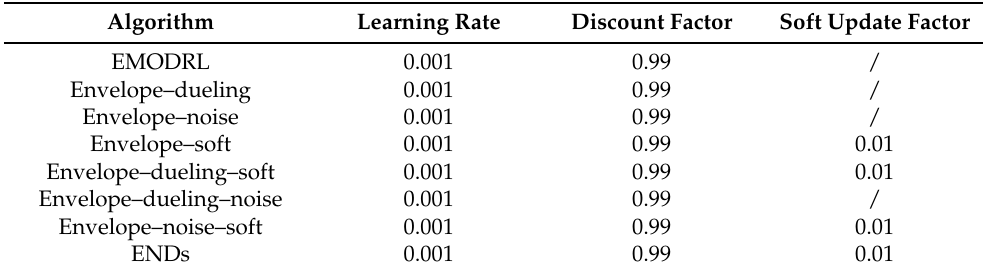
Table 1. Parameter settings of the different algorithms.